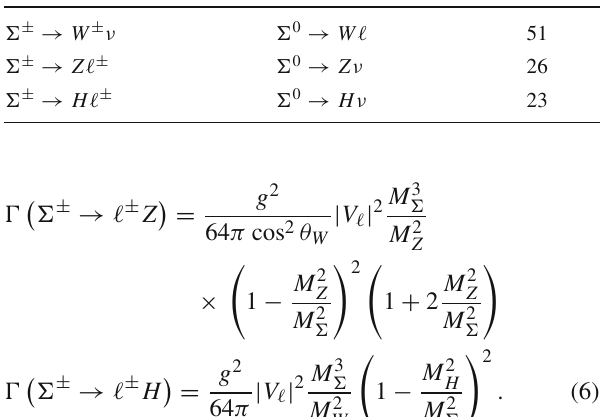
Table 1 Branching ratio of the charged and neutral triplet fermion with mass, M (cid:2) = 500 GeV, with only one of V (cid:4) considered to be present, setting the other two to zero Decay (cid:2)